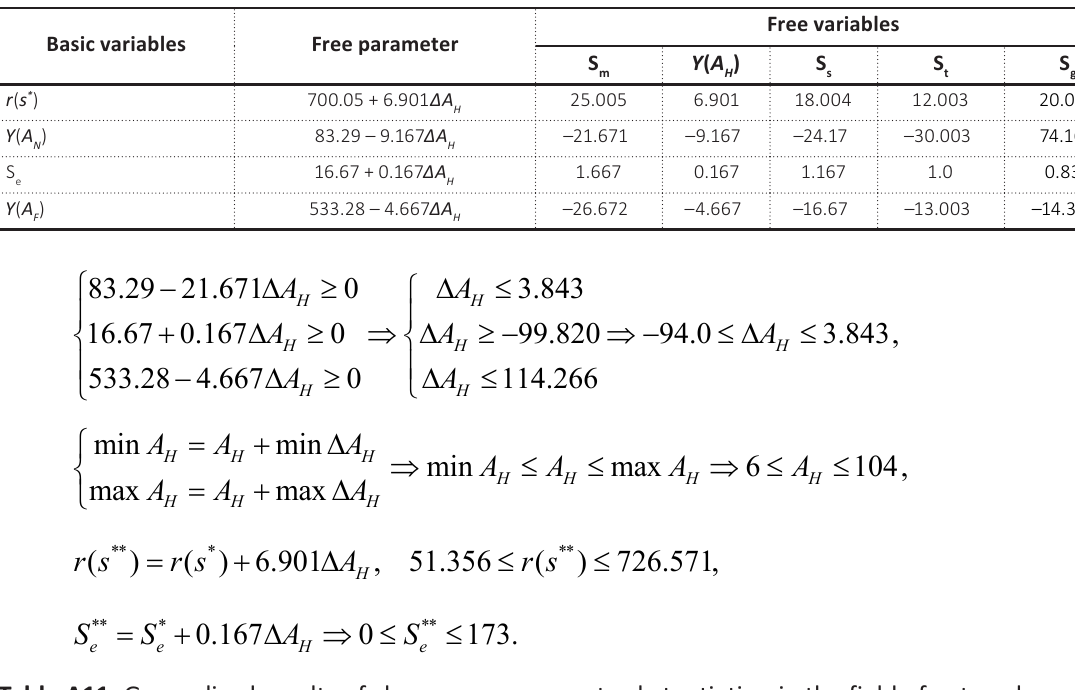
Table A11. Generalized results of change management substantiation in the field of nature-based tourism using the model of linear programming Indicators by groups of nature–based tourism services